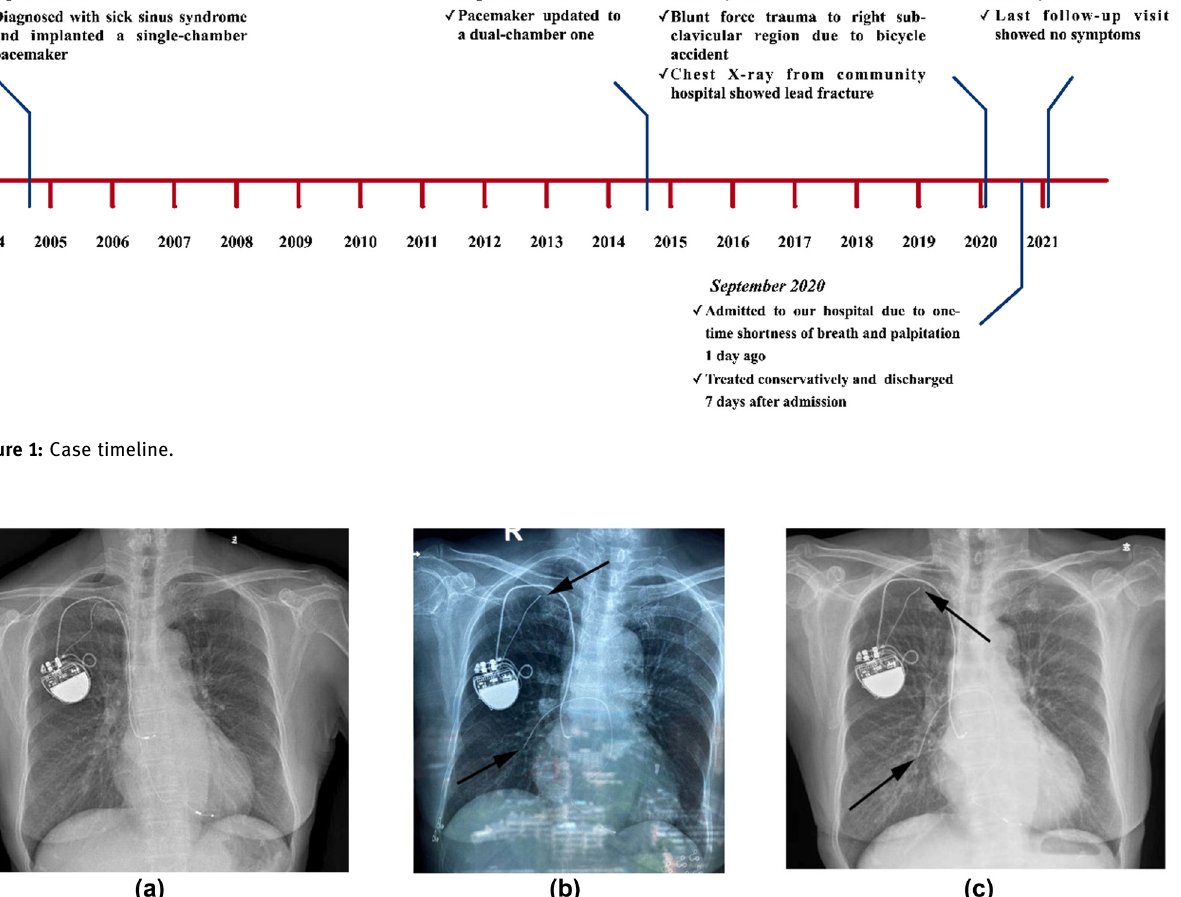
Figure 2: Chest X - ray images from December 2019 ( a ) showing both leads were intact, while results from January 2020 ( b ) and September 2020 ( c ) showing a complete right - ventricular lead fracture ( arrow ) .